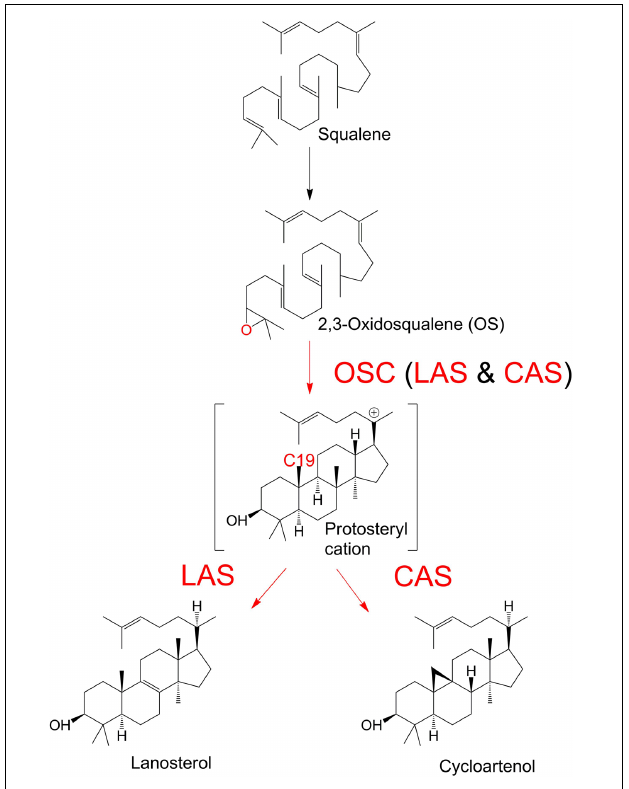
FIGURE 1 | Enzymatic cyclisation of 2,3-oxidosqualene (OS) to lanosterol (LA) and cycloartenol (CA). Oxidosqualene cyclase enzymes (OSC) protonate the OS substrate, leading to the production of LA or